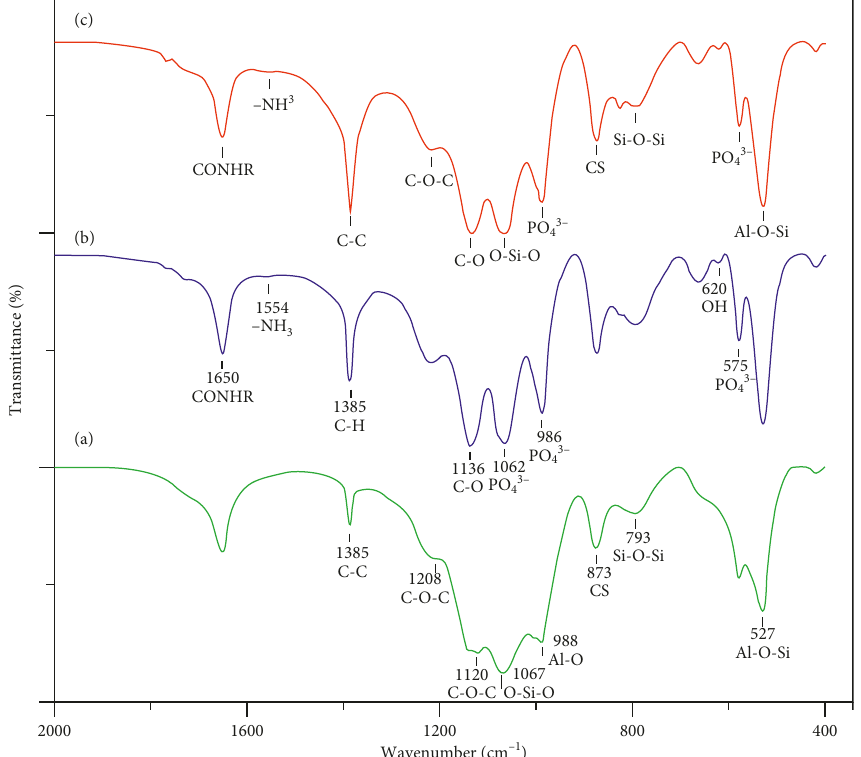
Figure 2: FTIR spectra of (a) PEDOT-HNT, (b) CS-MHA, and (c) PEDOT-HNT/CS-MHA bilayer composite